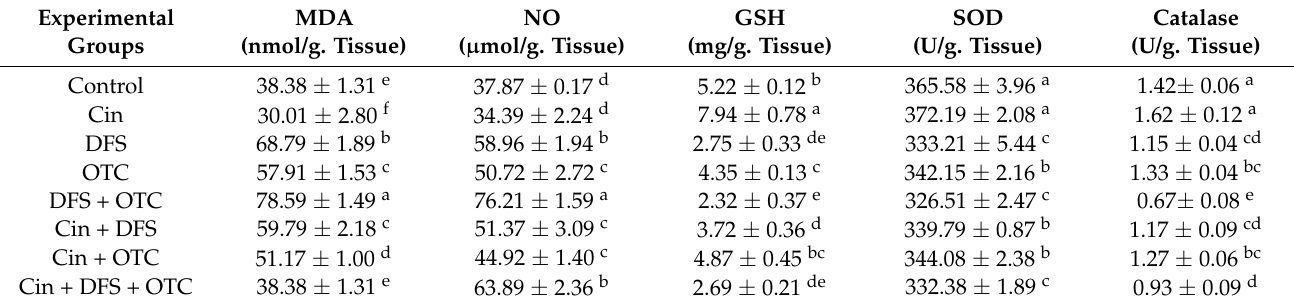
Table 5. Renal antioxidant and oxidative stress parameters in control and experimental groups. Experimental